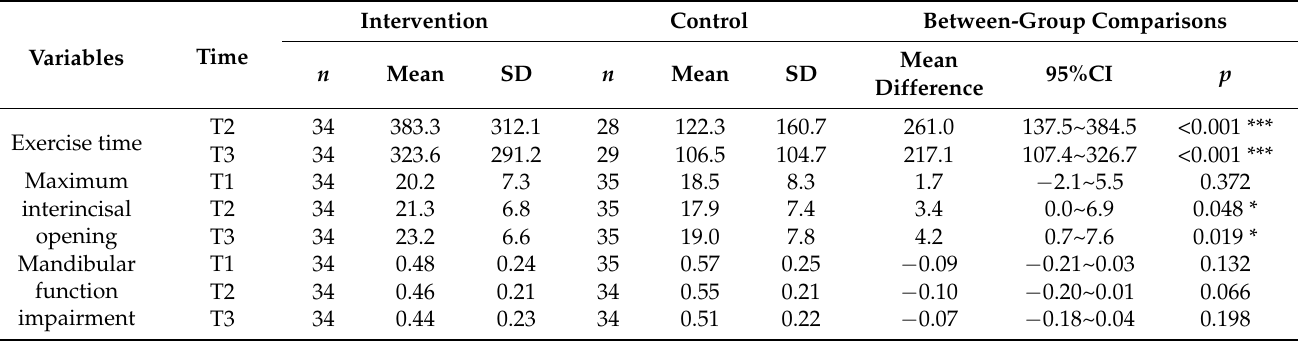
Table 2. Between-group comparisons on the exercise time, maximum interincisal opening, and mandibular function impairment at three time